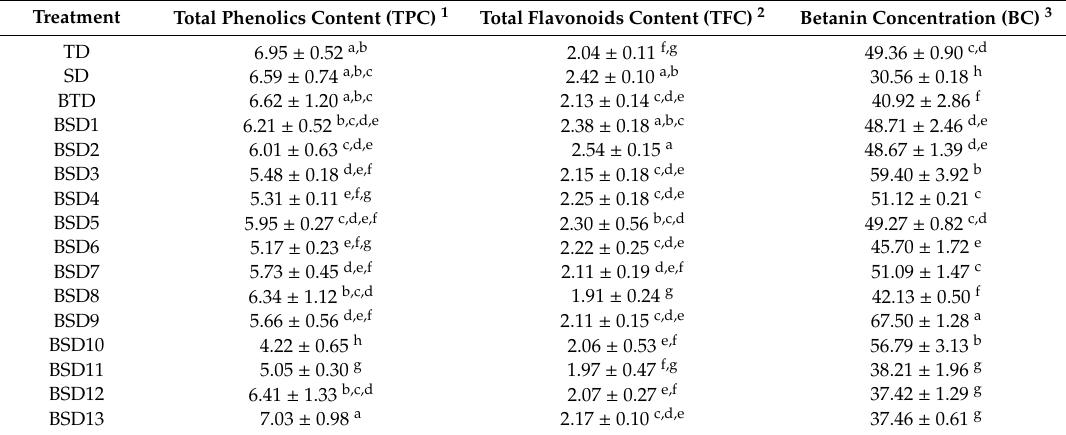
Table 1. Total Phenolics Content (TPC), Total Flavonoids Content (TFC), and Betanin Concentration (BC) of red dried beetroots.